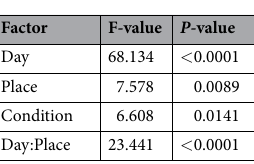
Table 2. F-statistic (ANOVA) of the most parsimonious model (Shift ~ Day + Place + Condition + Day:Place) using restricted maximum likelihood estimation